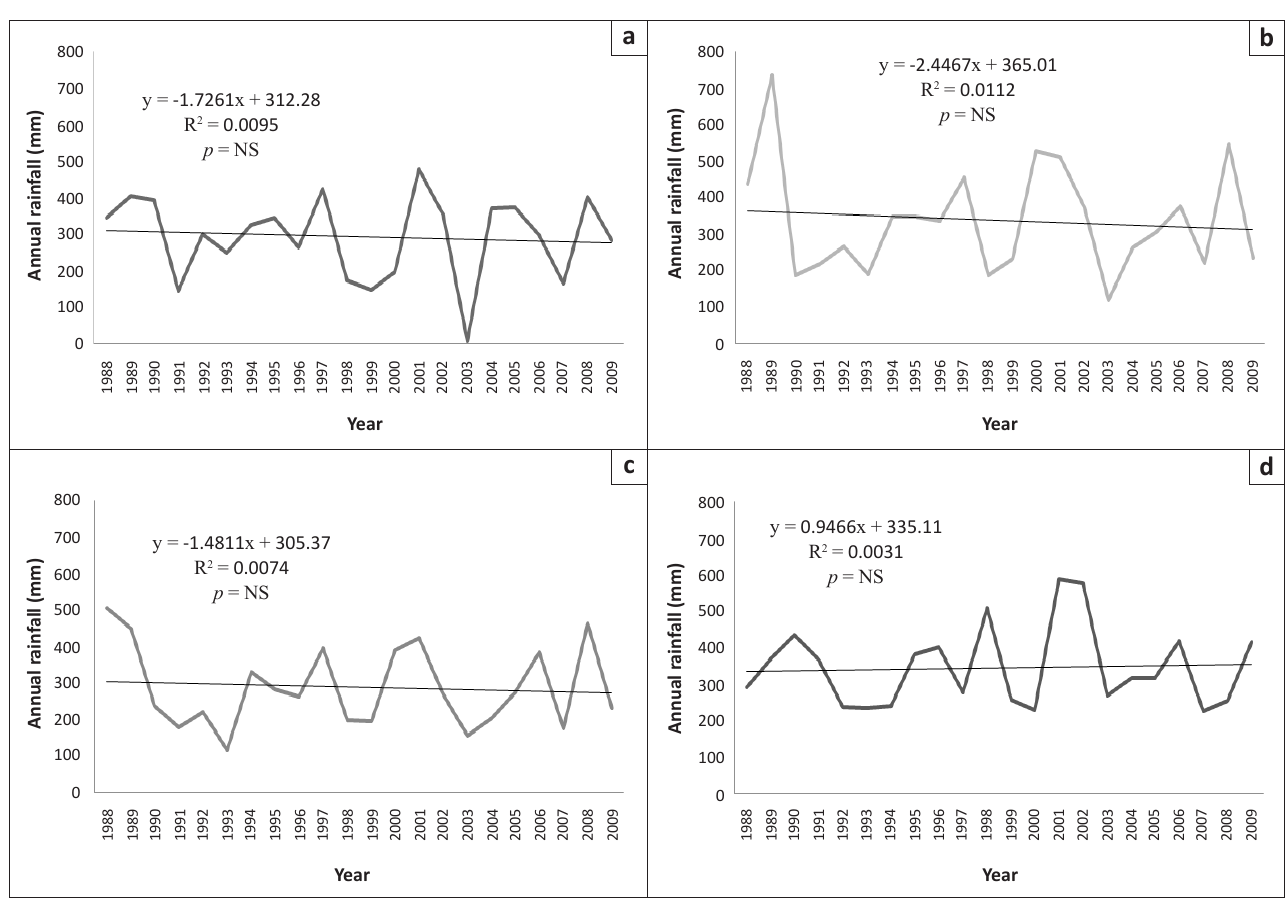
FIGURE 1: Annual rainfall totals for four climate stations, (a) Spekbos, (b) Wildebeeskom, (c) Gannaleegte and (d) Nqweba Dam, within the Camdeboo National Park over the period